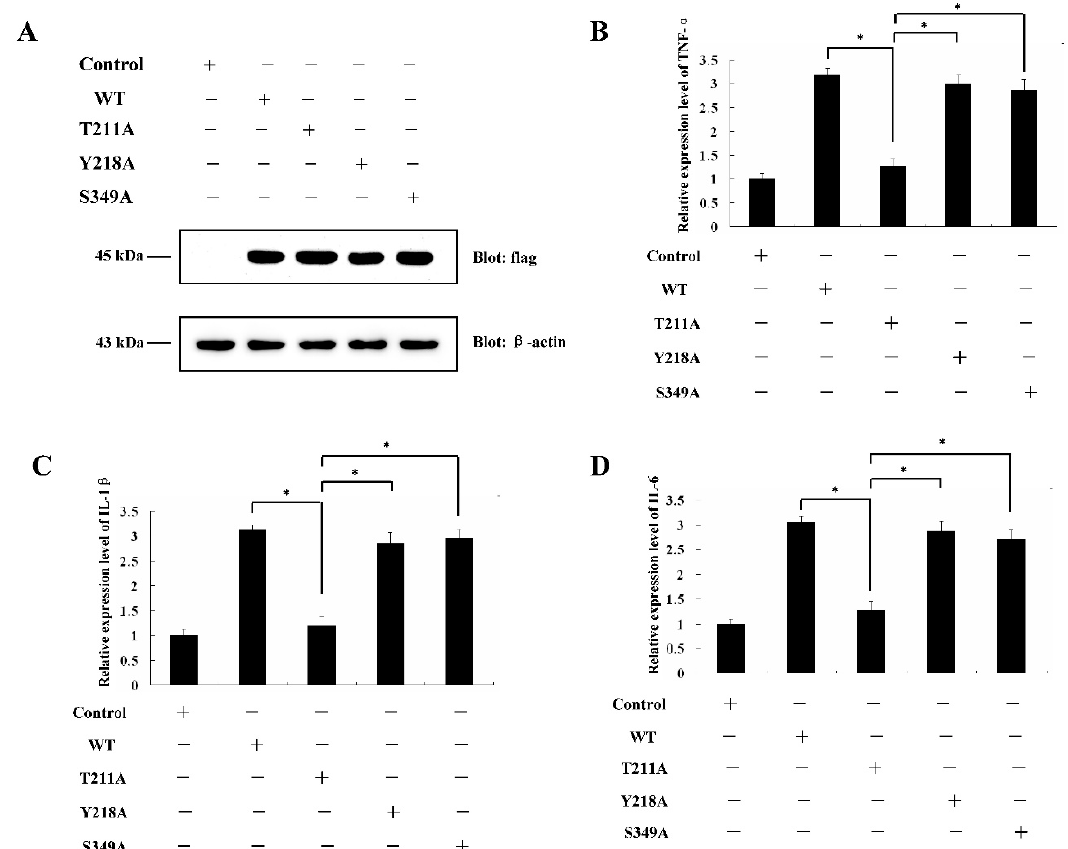
Figure 4. Determination of PKC- δ -like active sites on the cellular inflammation reaction. ( A ) The protein expression of WT, T211A, Y218A, or S349A in the RAW264.7 cells was detected. ( B ) The mRNA levels of TNF- α in the RAW264.7 cells, which were transfected with WT, T211A, Y218A, or S349A, were detected. ( C ) The mRNA levels of IL-1 β in the RAW264.7 cells, which were transfected with WT, T211A, Y218A, or S349A, were detected. ( D ) The mRNA levels of IL-6 in the RAW264.7 cells, which were transfected with WT, T211A, Y218A, or S349A, were detected. (WT: Wild type of PKC- δ -like-CF; T211A: PKC- δ -like-CF (T211A); Y218A: PKC- δ -like-CF (Y218A); S349A: PKC- δ -like-CF (S349A).) The asterisk indicates p < 0.05.